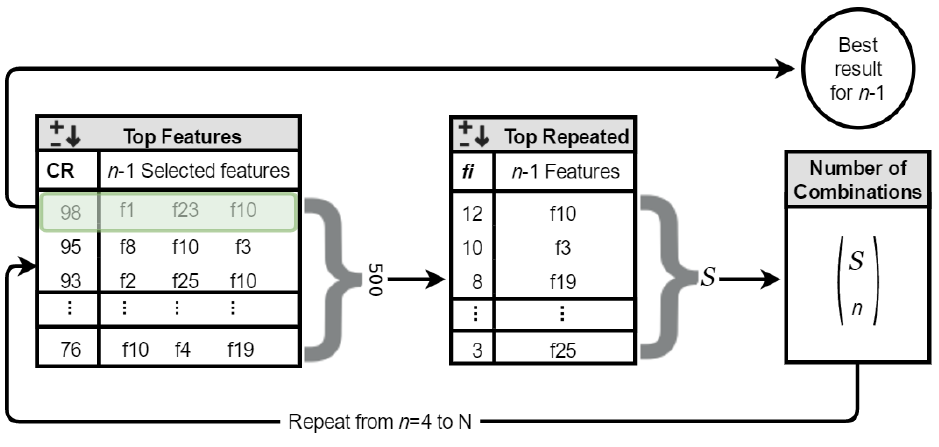
Figure 2. Proposed exhaustive-search-based quasi-optimal